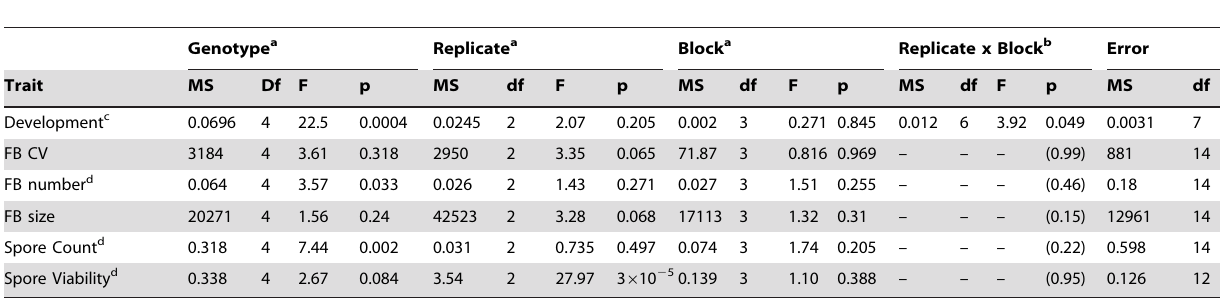
Table 1. Variation among genotypes for developmental